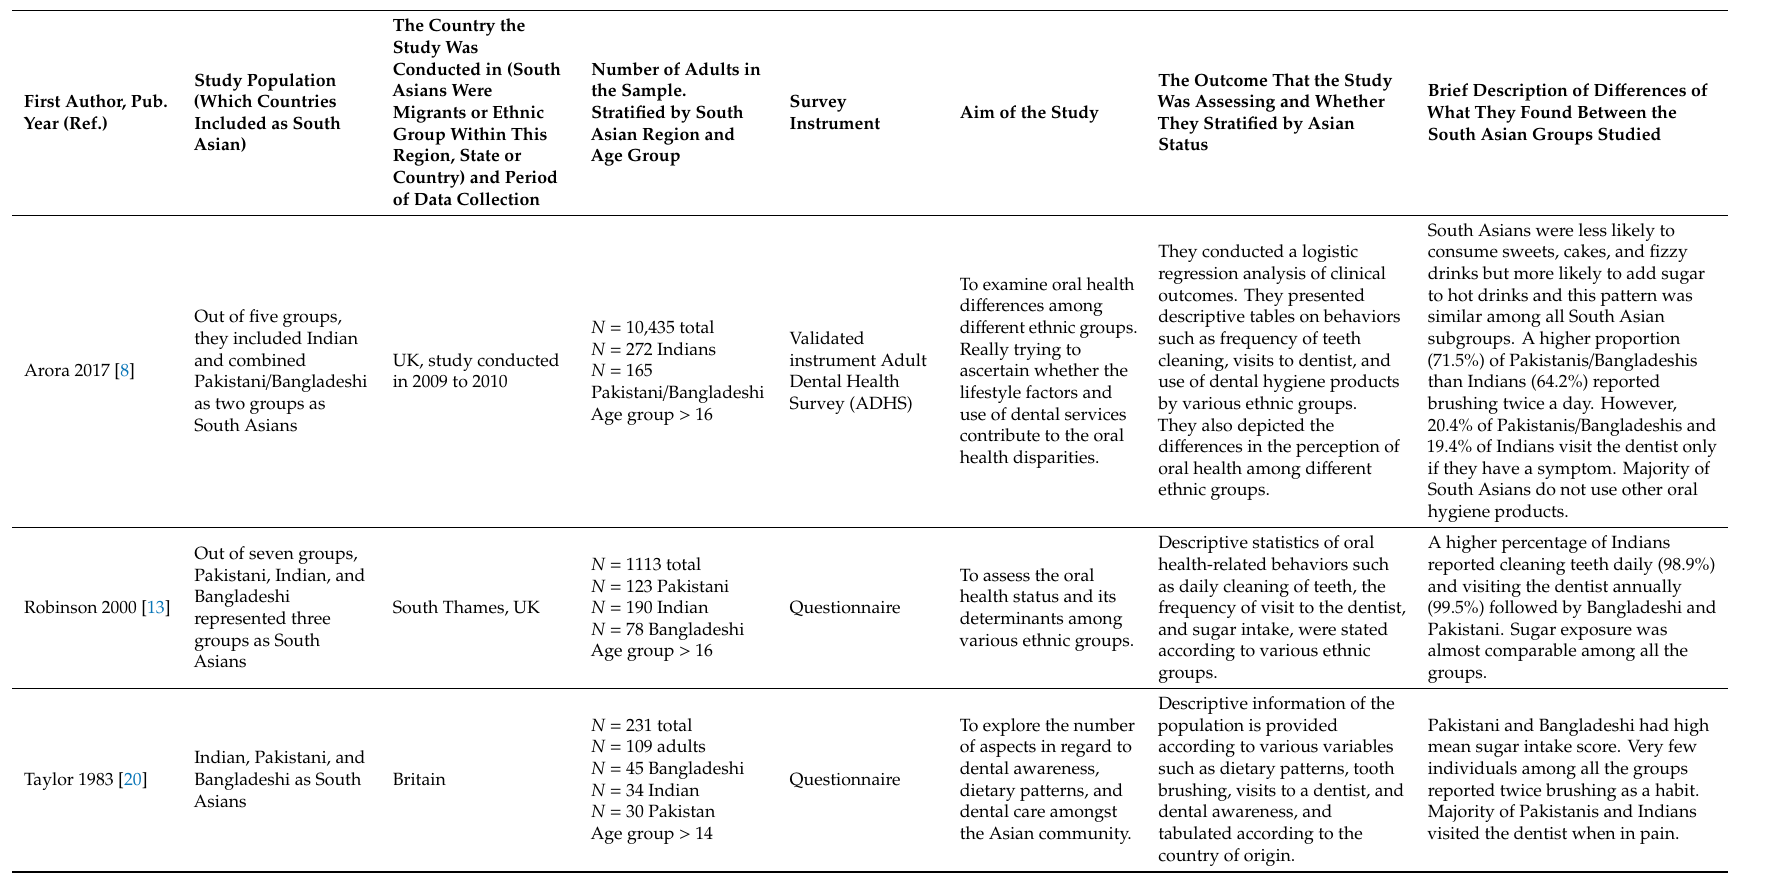
Table 3. Summary characteristics table of quantitative